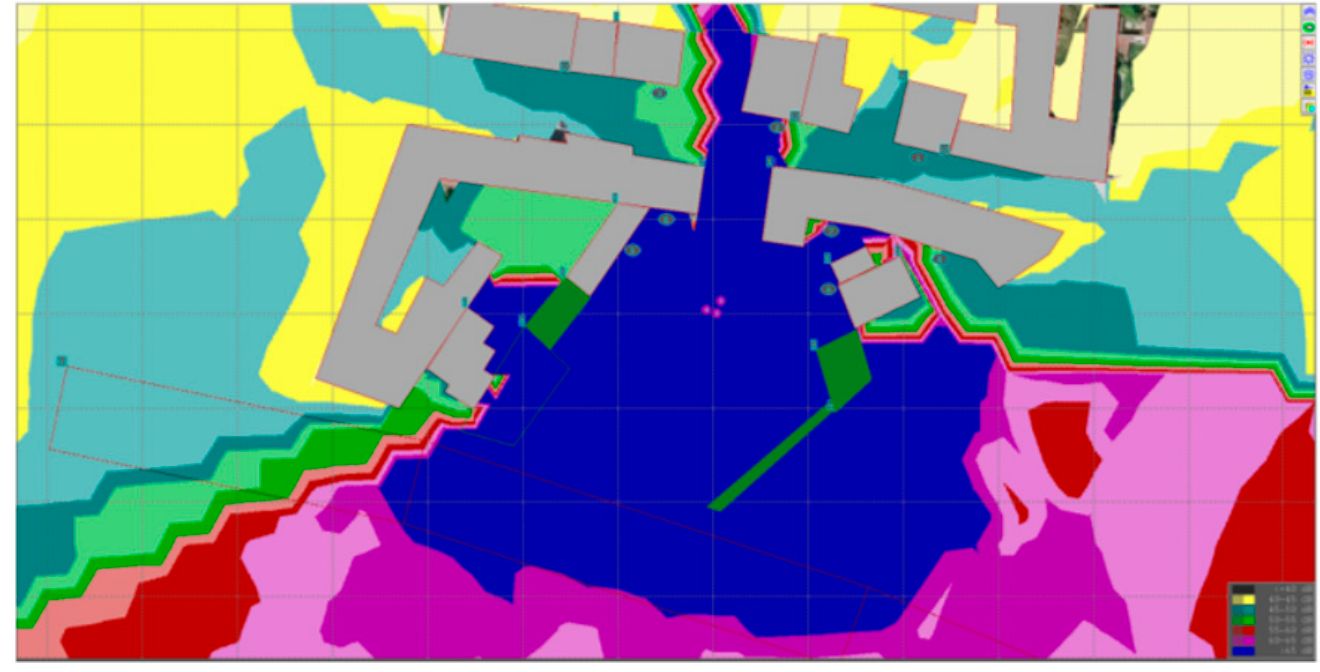
Figure 12. Colour map of isophone bands after considering acoustically significant elements (without construction site fencing or a solid gate) for pile-driving work in the investigated area. Table 14. Table of points from the calculation of measured points for earthworks without construction site fencing or a solid gate for pile-driving work in the investigated area.